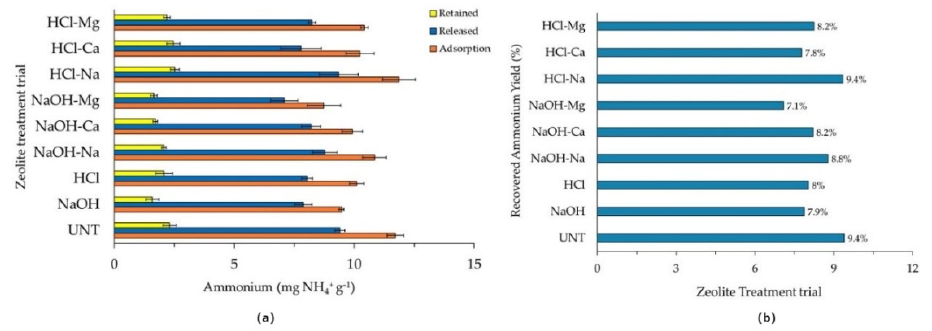
Figure 13. Amount of NH 4 + adsorbed, released and retained by the different treatments ( a ). Percentage of ammonium recovered from the ammonium solution (process efficiency) compared to the ammonium exchange capacity of treated clinoptilolite ( b ).